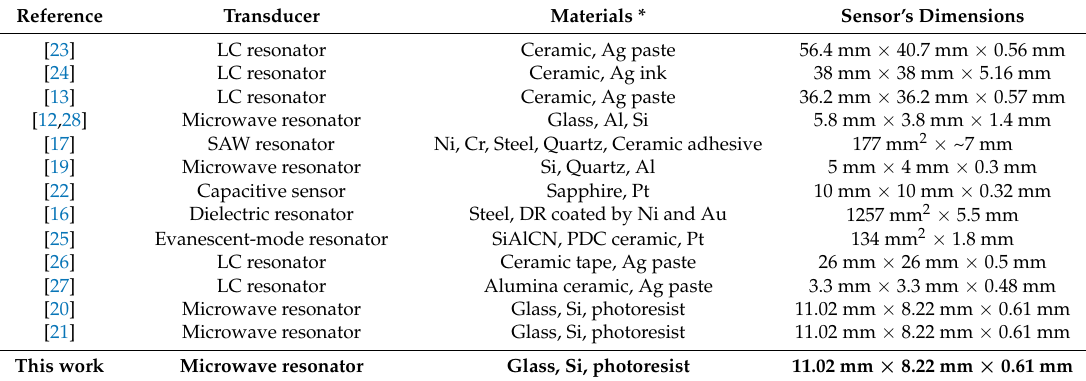
Table 2. Characteristics of published wireless and passive pressure sensors—materials and